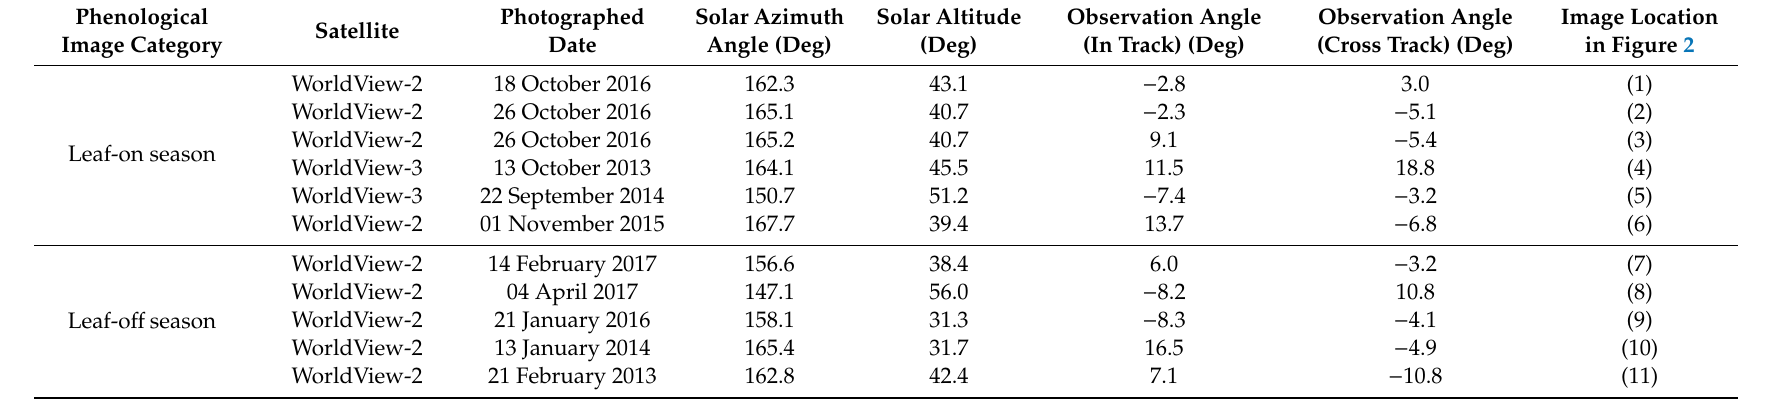
Table 1. Detailed information on WorldView-2 / 3 imagery used in this